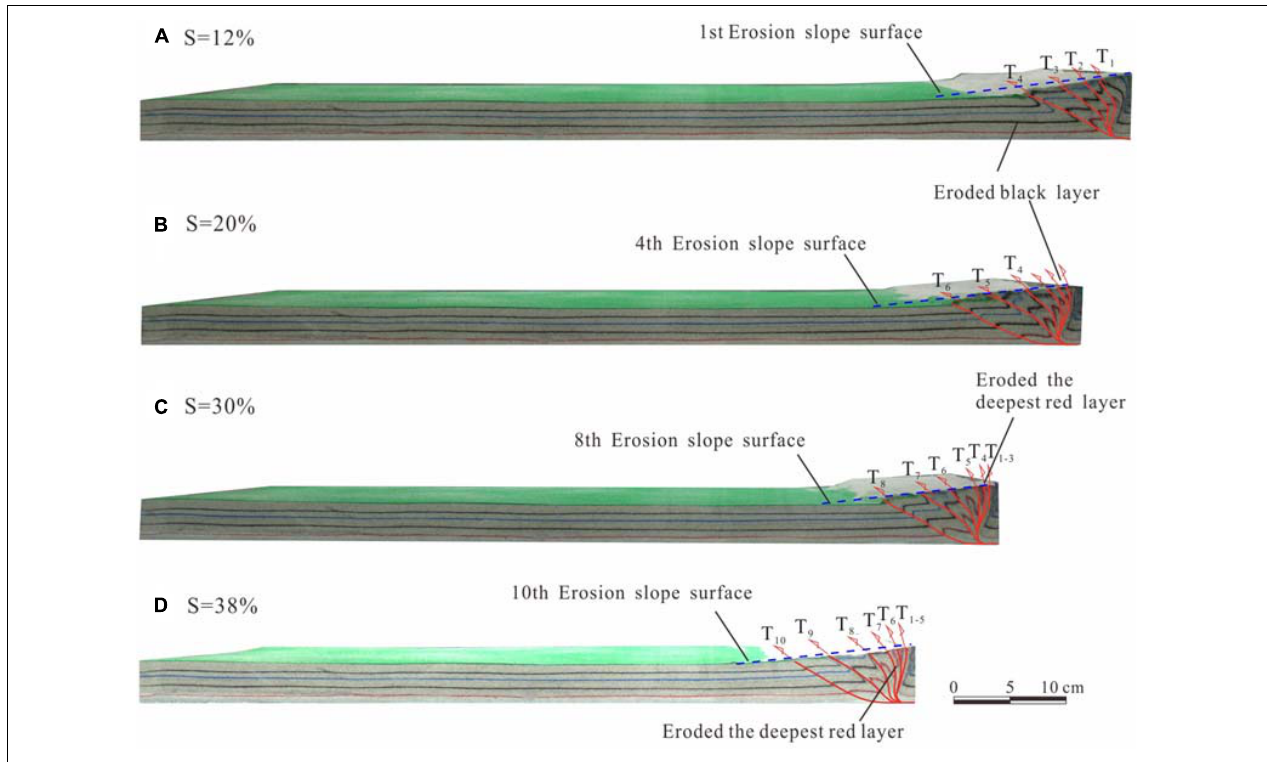
FIGURE 3 | Experiment results of high rate of erosion model (E1). (A–D) Sequential photographs showing the structural evolution of